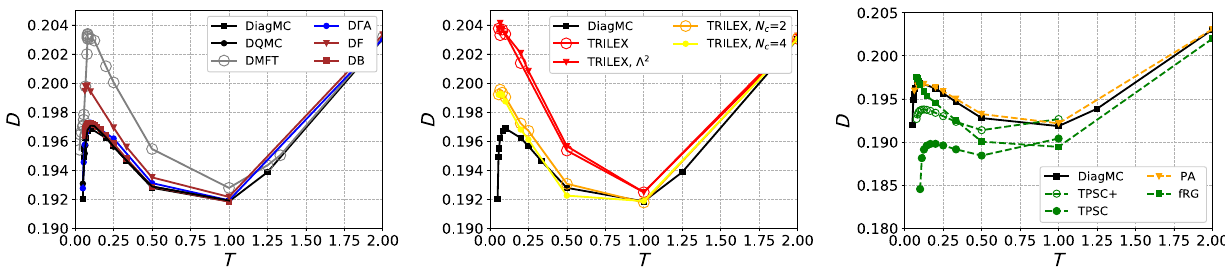
FIG. 12. Double occupancy D as a function of temperature from various